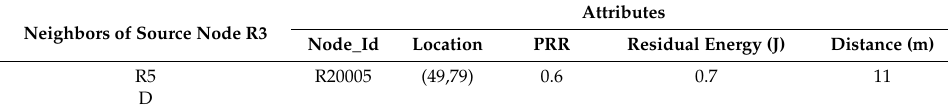
Table 7. Description of neighbors of R3 along with its